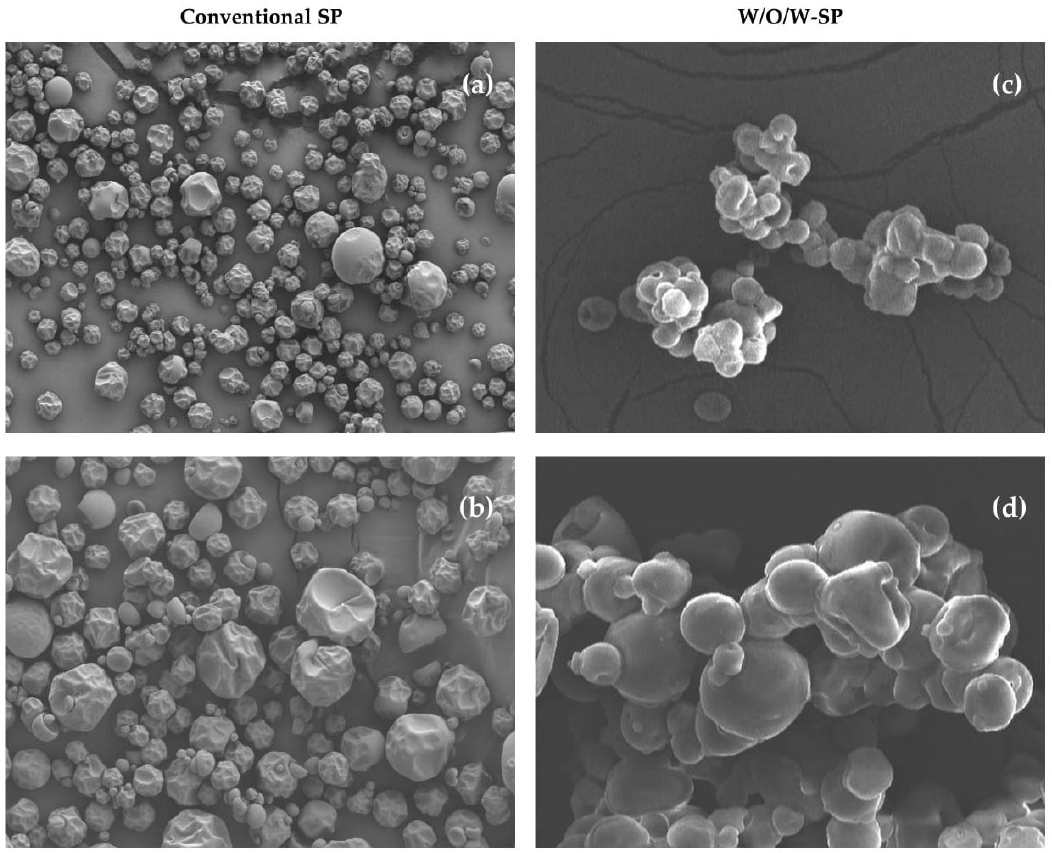
Figure 6. Surface morphology images of powder microcapsules obtained with conventional SP and W/O/W-SP at 160–80 °C as drying conditions: ( a , c ) 500× magnification, ( b , d ) 1000× magnification, all at 2 kV.